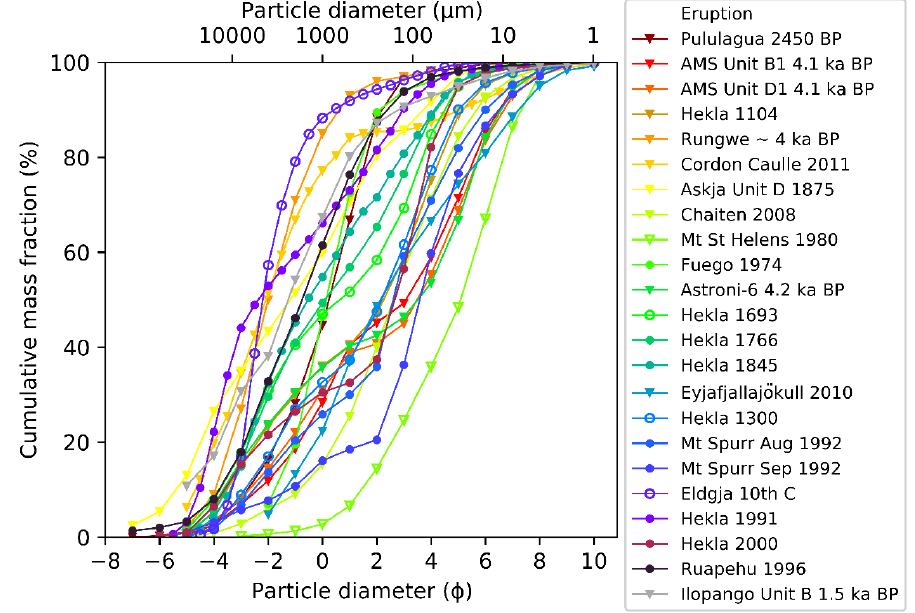
Figure 2. Total grain size distributions for selected magmatic eruptions based on deposits. The legend lists eruptions in order of VEI (large to small; see Table 2). AMS = Campi Flegrei, Agnano Monte Spina. Magma composition: ▽ silicic, o mafic/intermediate.